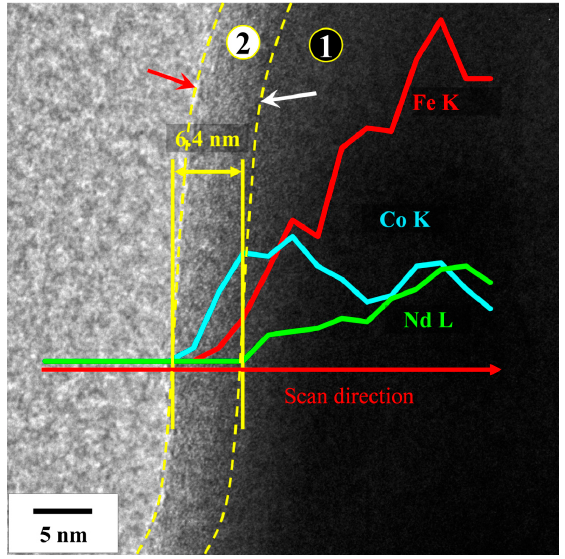
Figure 4. TEM image along with EDX line map taken from surface of the plated powder.